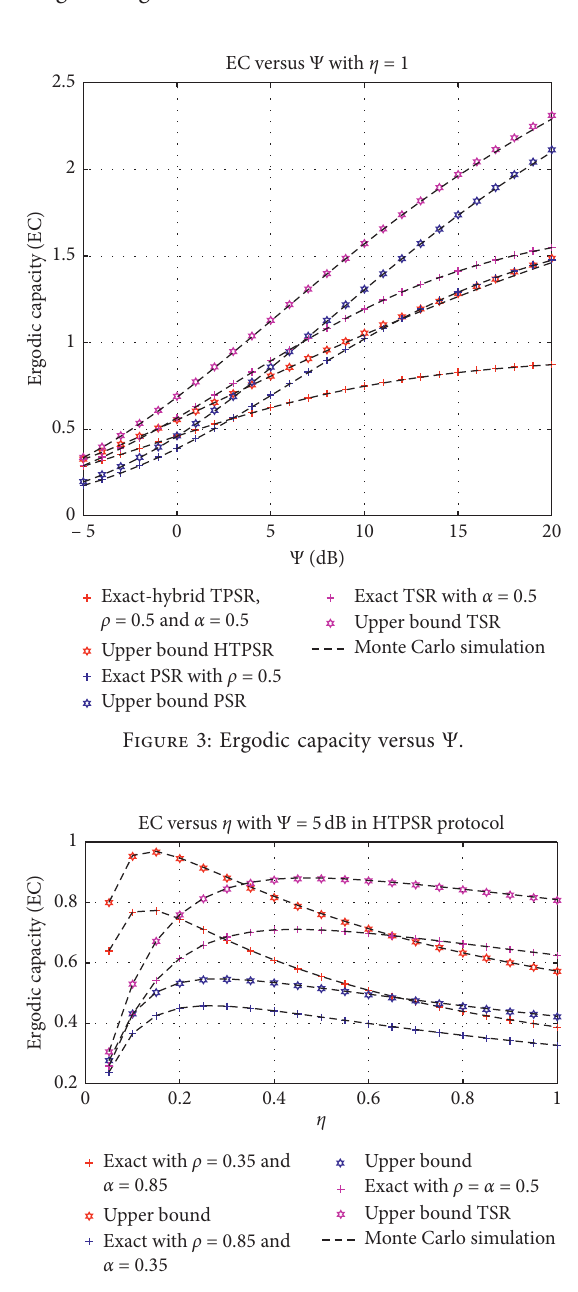
Figure 4: Ergodic capacity versus η for HTPSR protocol.